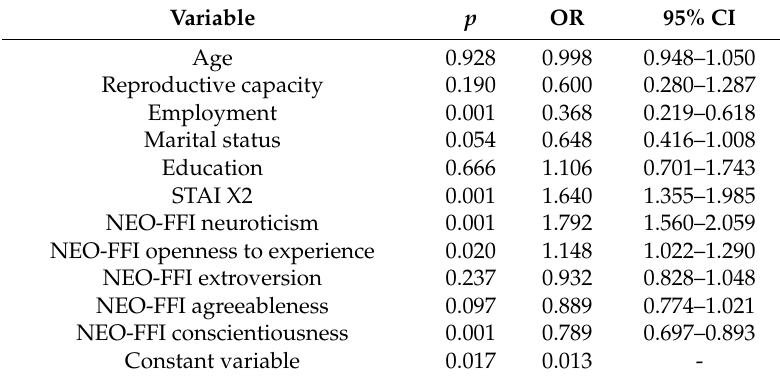
Table 5. Multiple logistic regression analysis of the influence of selected variables on depressive symptoms according to the